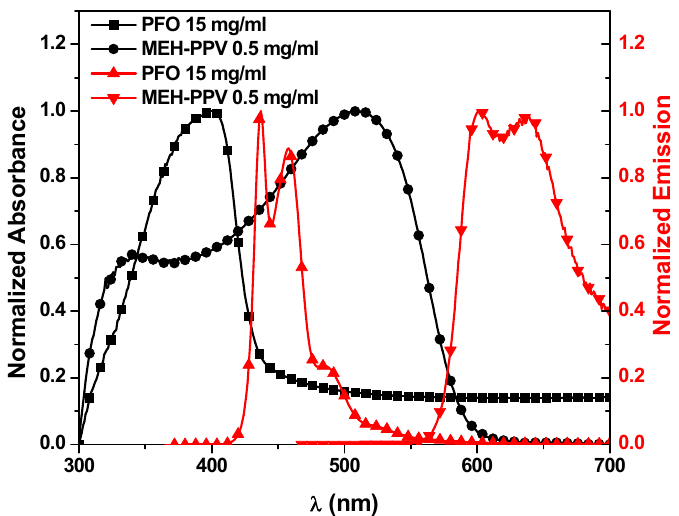
Figure 1. Normalized absorbance (black color) and emission spectra (red color) of PFO and MEH-PPV thin films.